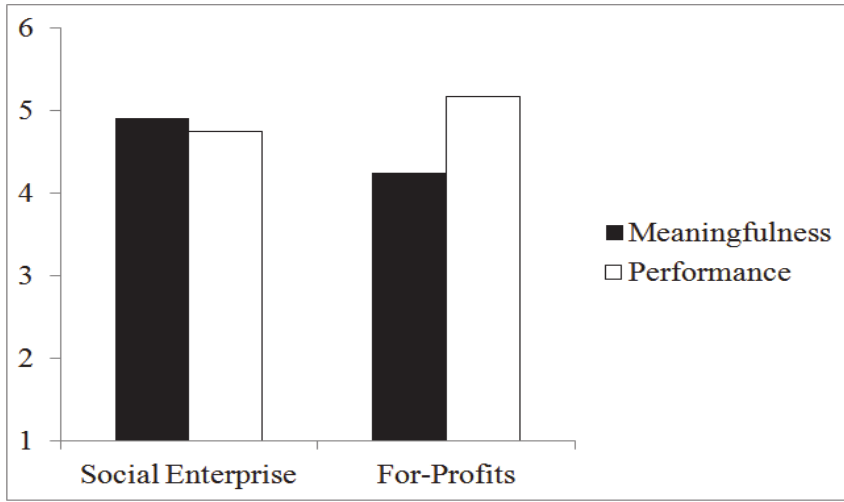
<Figure 2> Meaningfulness and Performance as a Function of the Enterprise Type